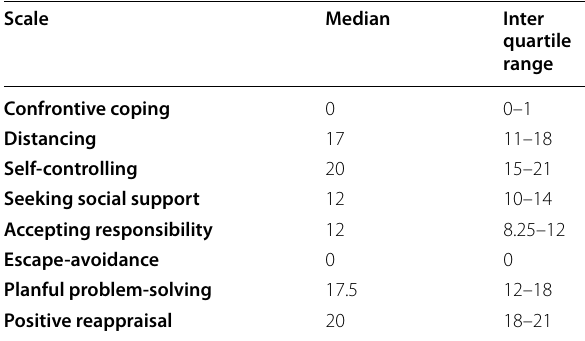
Table 3 Spearman correlation between Perceived Stress Scale (PSS) and quality of life (QoL)